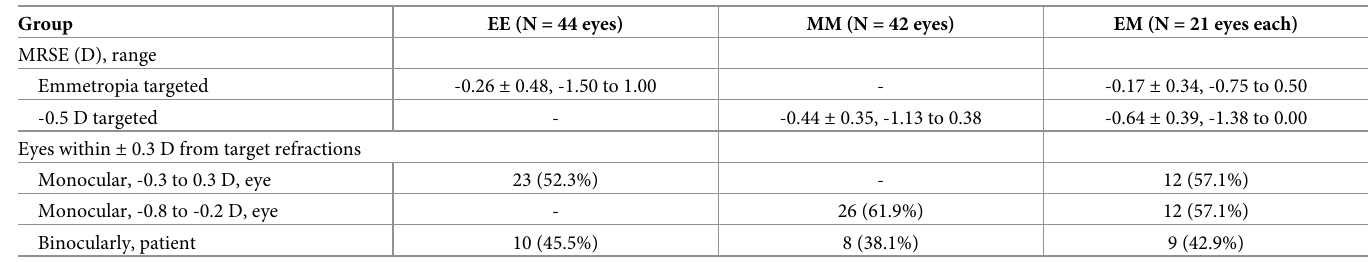
Table 2. Postoperative manifest refractions spherical equivalent (MRSE) in the three groups.